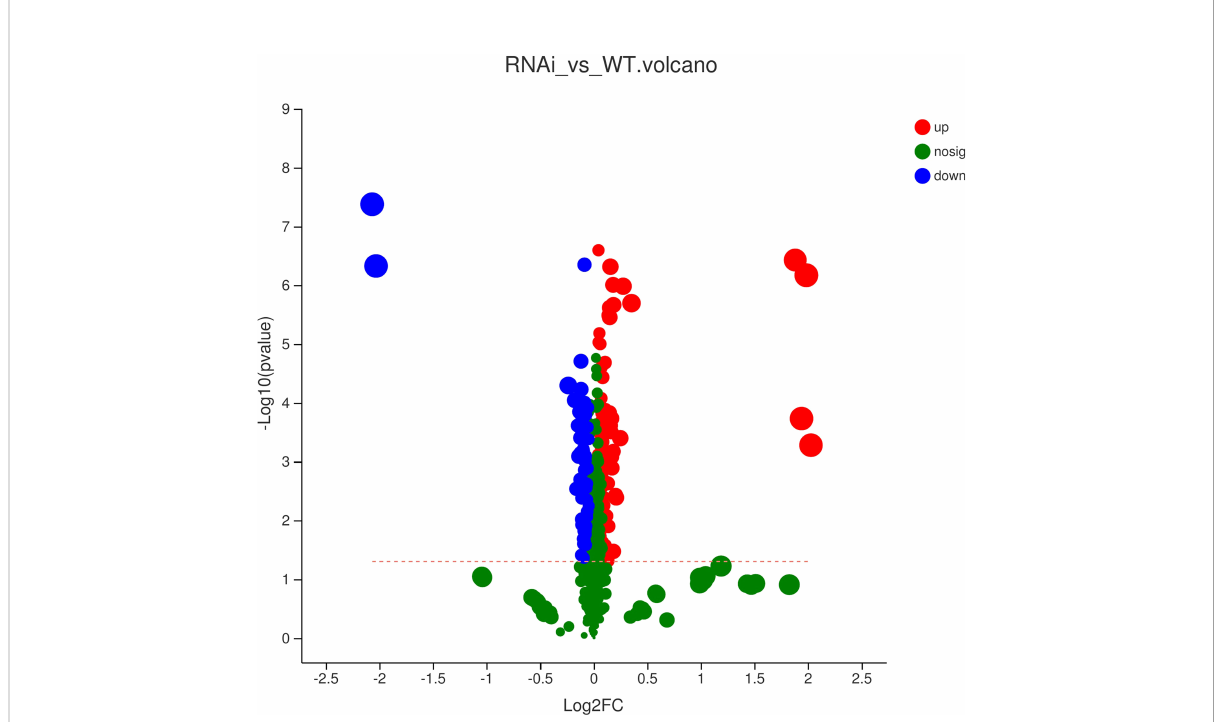
FIGURE 8 Volcano map of metabolic differences of wild-type and transgenic rapeseed plants (RNAi vs. WT). Note: Each dot in the fi gure represents a speci fi c metabolite, and the size of the dot indicates the VIP value (the importance of the independent variable x in explaining the dependent variable y ). The blue dots on the left are differentially downregulated metabolites, and the red dots on the right are differentially upregulated metabolites. The more dots on the left and right there are, the more signi fi cant the differences, and the higher the ordinate value is, the more signi fi cant the expression